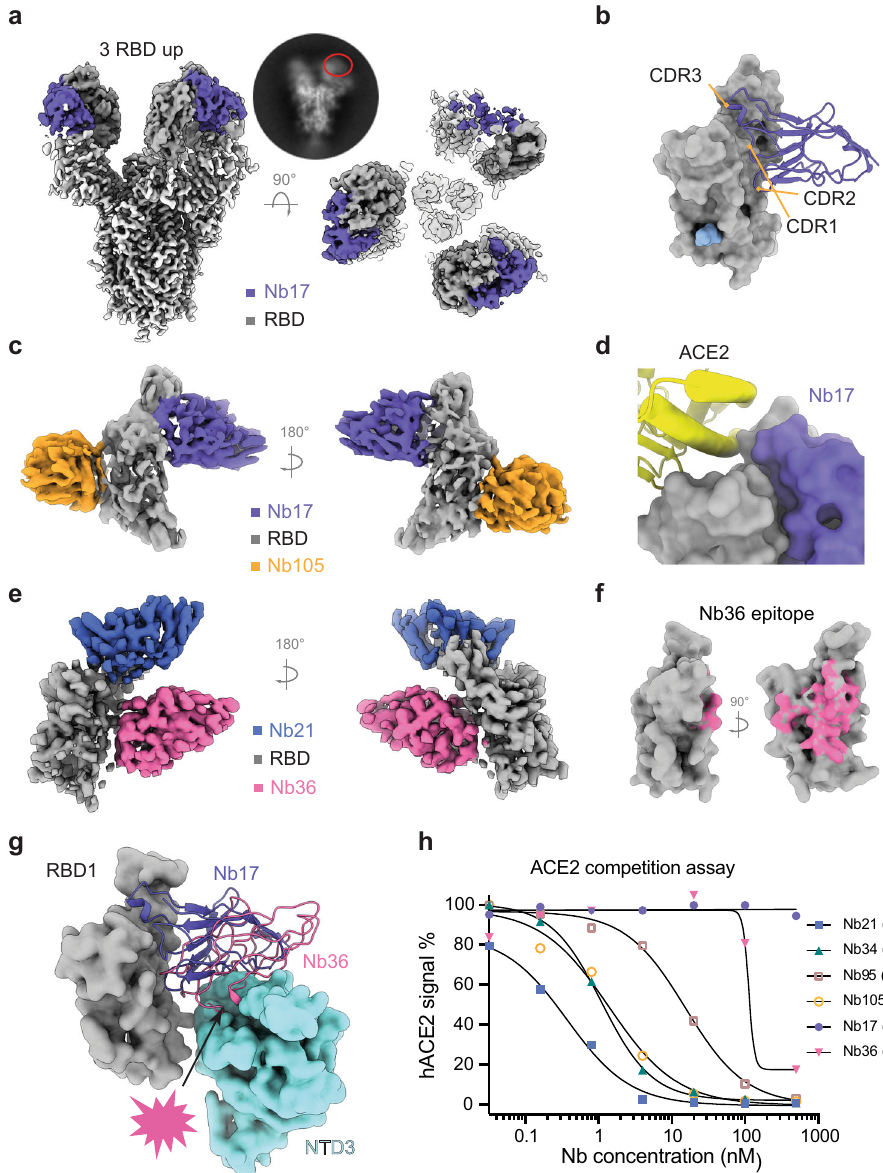
Fig. 4 Structures of class III Nbs (17 and 36). a Cryo-EM structures of Nb17 in complex with S. b Nb17:RBD interactions are mediated by all three CDRs. c Cryo-EM structure of the Nb17:Nb105:RBD complex. d Nb17 structurally does not overlap with ACE2. e Cryo-EM structure of the Nb36:Nb21:RBD complex. f Epitope of Nb36 on the RBD surface. g Nb17 stacks on NTD via its framework, while isolated Nb36:RBD complex indicates Nb36 would clash with neighboring NTD on S. h ACE2 competition assay with the